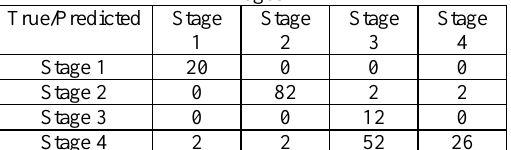
Figure 16. Confusion Matrix of 200 Raw Images, of 84% TF